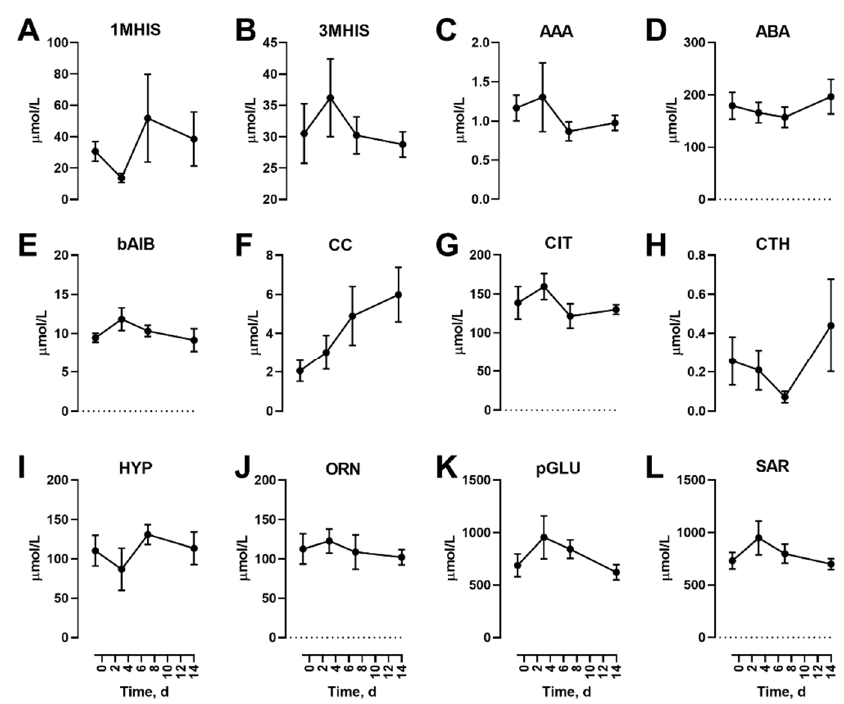
Figure 1 . Effects of dietary protein restriction on blood serum proteinogenic amino acids during fasting. After an initial sample, young men ( n = 5) underwent a 7 d period of consuming a protein- restricted diet, followed by a 7 d diet matching habitual protein intake (NPD), with blood samples taken in the overnight fasted state before, 3 d and 7 d after LPD, and at 7 d after NPD feeding. ( A ), schematic of the study design. The blood drops represent the fasting samples and M represents an isocaloric meal tolerance test. Blood serum amino acid levels including the non-essential amino acids (NEAAs) alanine ( B ), arginine ( C ), asparagine ( D ), aspartate ( E ), glutamine ( F ), glutamate ( G ), glycine ( H ), proline ( I ), serine ( J ), and tyrosine (K); and essential amino acids (EAAs) histidine ( L ), isoleucine ( M ), leucine ( N ), lysine ( O ), methionine ( P ), phenylalanine ( Q ), threonine ( R ), tryptophan ( S ) and valine ( T ) were measured. Data are the mean ± SEM. One-way RM ANOVA, different than time − 1: * p < 0.05. In addition to the proteinogenic AAs, non-proteinogenic AAs were also measured. Of these, none were a ff ected by the diet feeding in the fasted state (Figure 2).